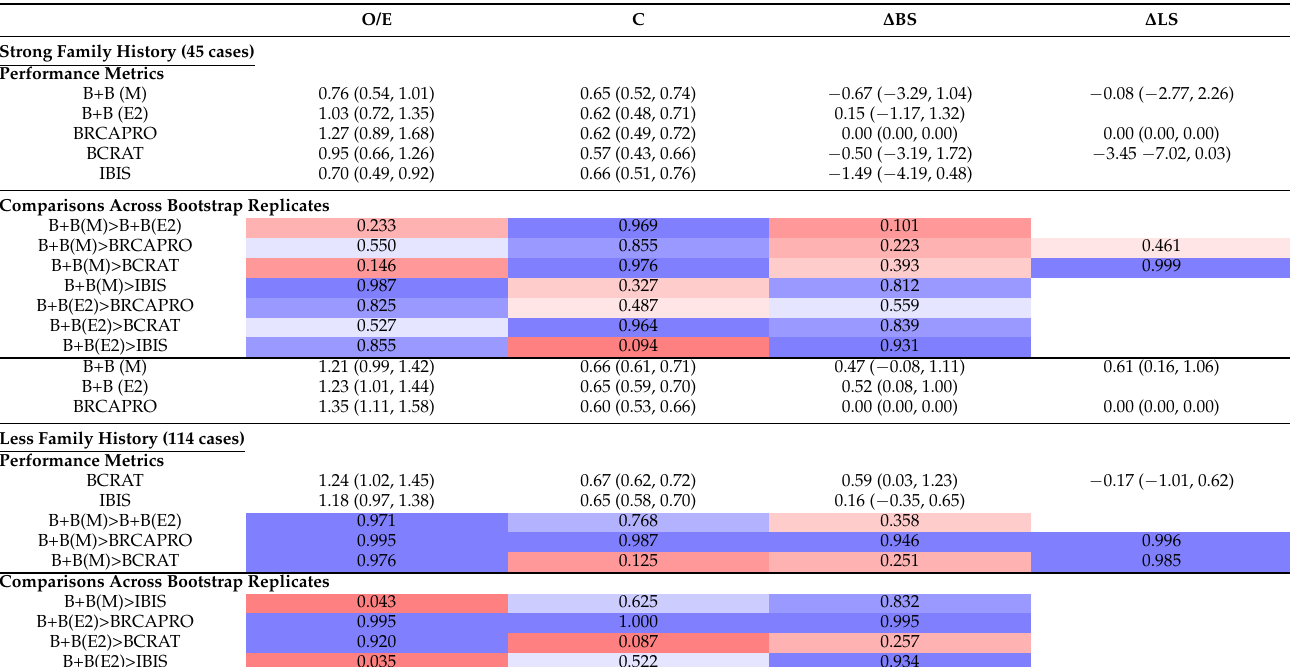
Table A6. Performance over follow-up period in CGN cohort stratified by family history (whether or not the proband met the NCCN criteria for further genetic risk evaluation [55]); in applying the criteria, we only used information on breast and ovarian cancer diagnoses in relatives. B+B: BRCAPRO + BCRAT. ∆ BS: % relative improvement in Brier Score compared to BRCAPRO. The “Comparisons Across Bootstrap Replicates” section shows pairwise comparisons involving the combination models across 1000 bootstrap replicates of the validation dataset; the row for A > B shows the proportion of bootstrap replicates where model A outperformed model B with respect to each metric. Proportions > 0.5 are highlighted in blue (with darker shades of blue for higher proportions) and proportions ≤ 0.5 are highlighted in red (with darker shades of red for lower